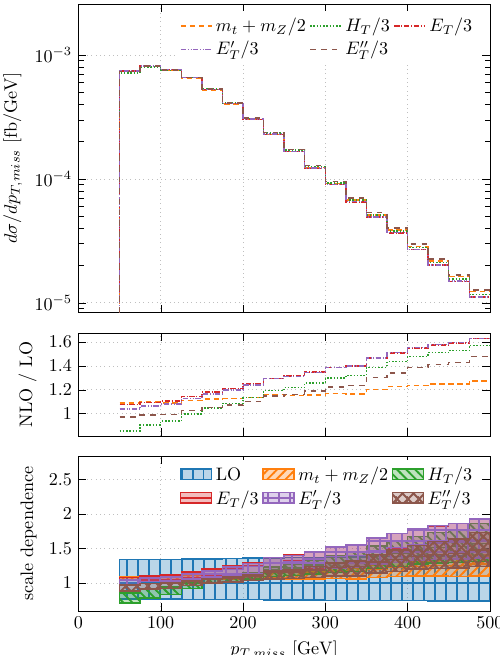
Figure 9 . The pp e + (cid:23) e (cid:22) (cid:0) (cid:22) (cid:23) (cid:22) b (cid:22) b (cid:23) (cid:28) (cid:22) (cid:23) (cid:28) + X di(cid:11)erential cross section distribution as a function of ! p miss at the LHC run II with p s = 13 TeV. The upper plots show absolute NLO QCD predictions T for various values of (cid:22) 0 where (cid:22) R = (cid:22) F = (cid:22) 0 . The middle panels display di(cid:11)erential The lower panels present di(cid:11)erential factors together with the uncertainty band from the scale K variation for various values of (cid:22) 0 . Also given is the relative scale uncertainties of the LO cross section for (cid:22) 0 = m t + m Z = 2. The LO and the NLO CT14 PDF sets are employed.